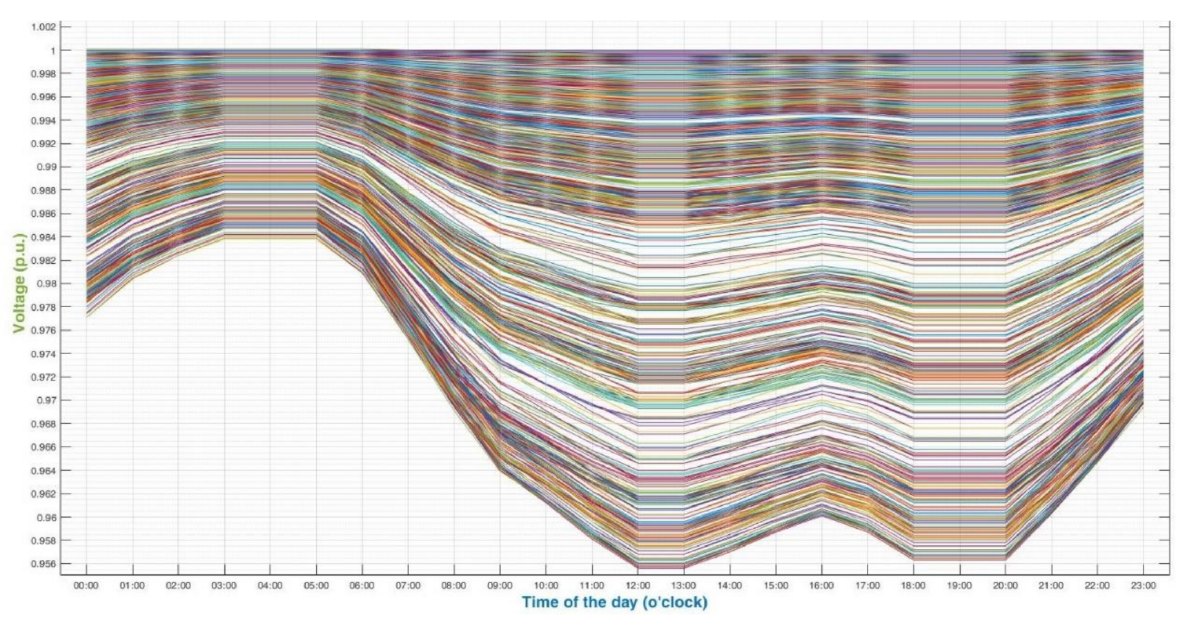
Figure 11. Voltage magnitude per unit of the buses for the LV and MV levels when CS1 is